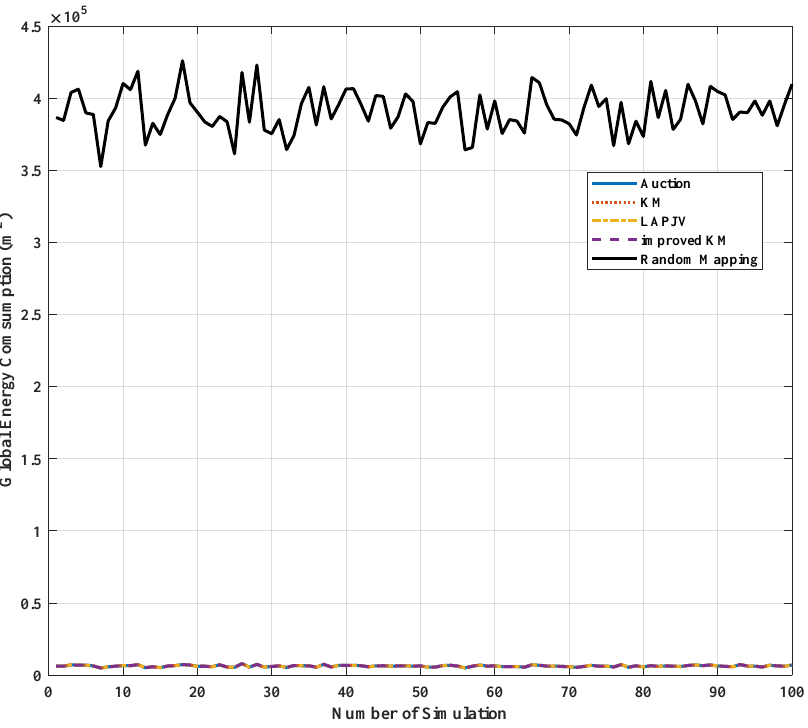
Figure 8. Global energy consumption comparison between the proposed method(LAPJV), the Auction algorithm, the KM algorithm, the improved KM algorithm and random mapping.